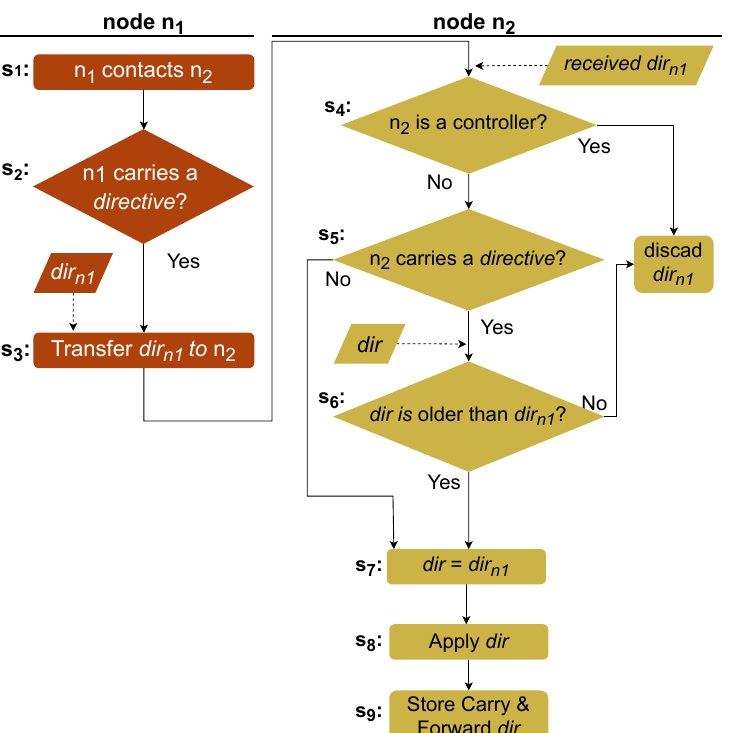
Figure 4. Disseminating a directive when two nodes are in